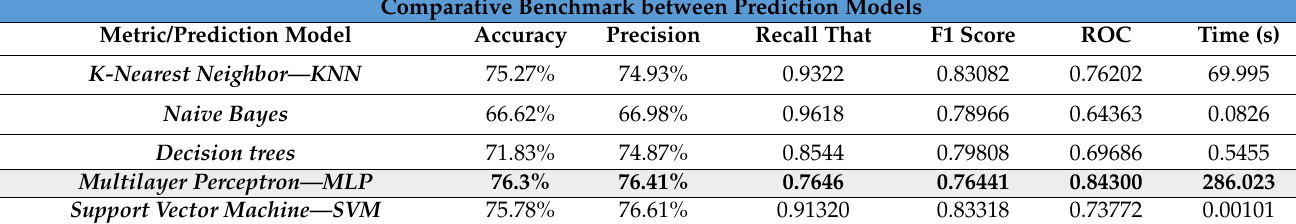
Table 10. Benchmark for prediction models.